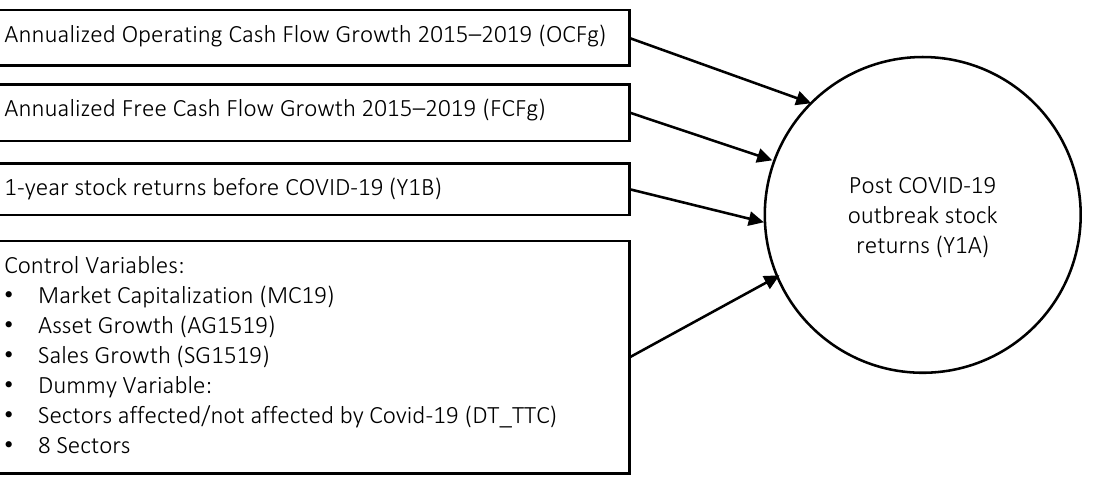
Figure 1. Research